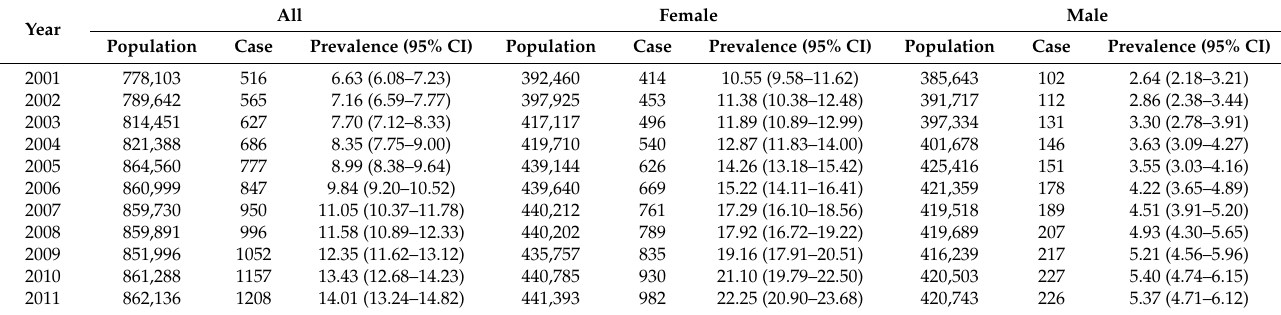
Table 1. Prevalence (per 10,000 people) of Rheumatoid Arthritis among 10–79 years old people in Taiwan from 2001 to 2011.